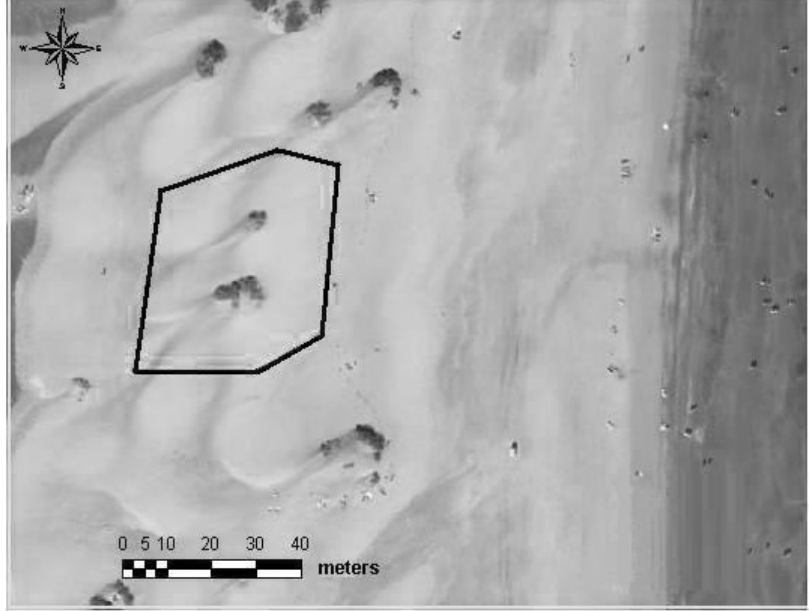
Figure 9. General view of the experimental plot. (Source: GRAFCAN